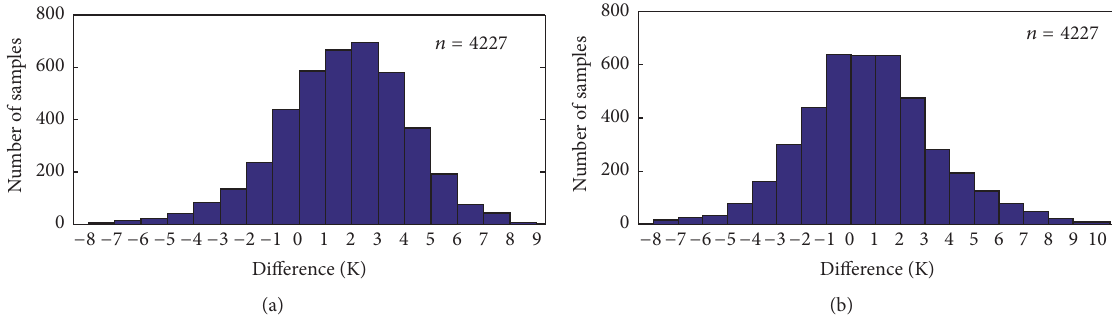
Figure 3: Statistical histograms of the accuracies of the BTM (a) and one-factor RTM (b) during the period of 2013-2014 at the three stations.